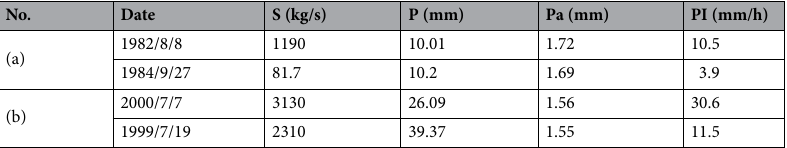
Table 5. Relationship between sediment, rainfall amount and rainfall intensity (hourly). P refers to the accumulated rainfall in a day; PI is the maximum rainfall intensity (mm/h) of 1 h.